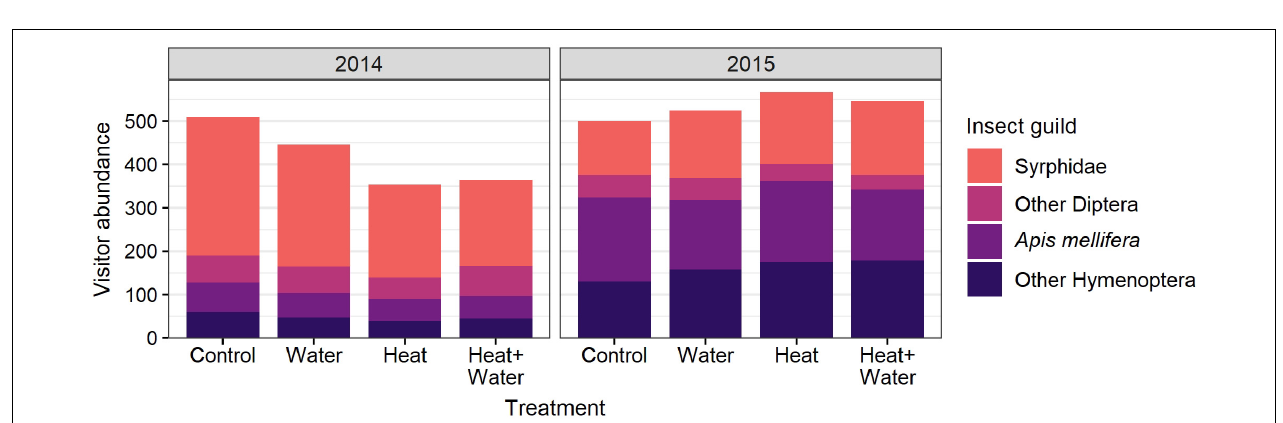
FIGURE 3 | Total abundance of flower-visitors belonging to different insect guilds in each treatment, in each year.